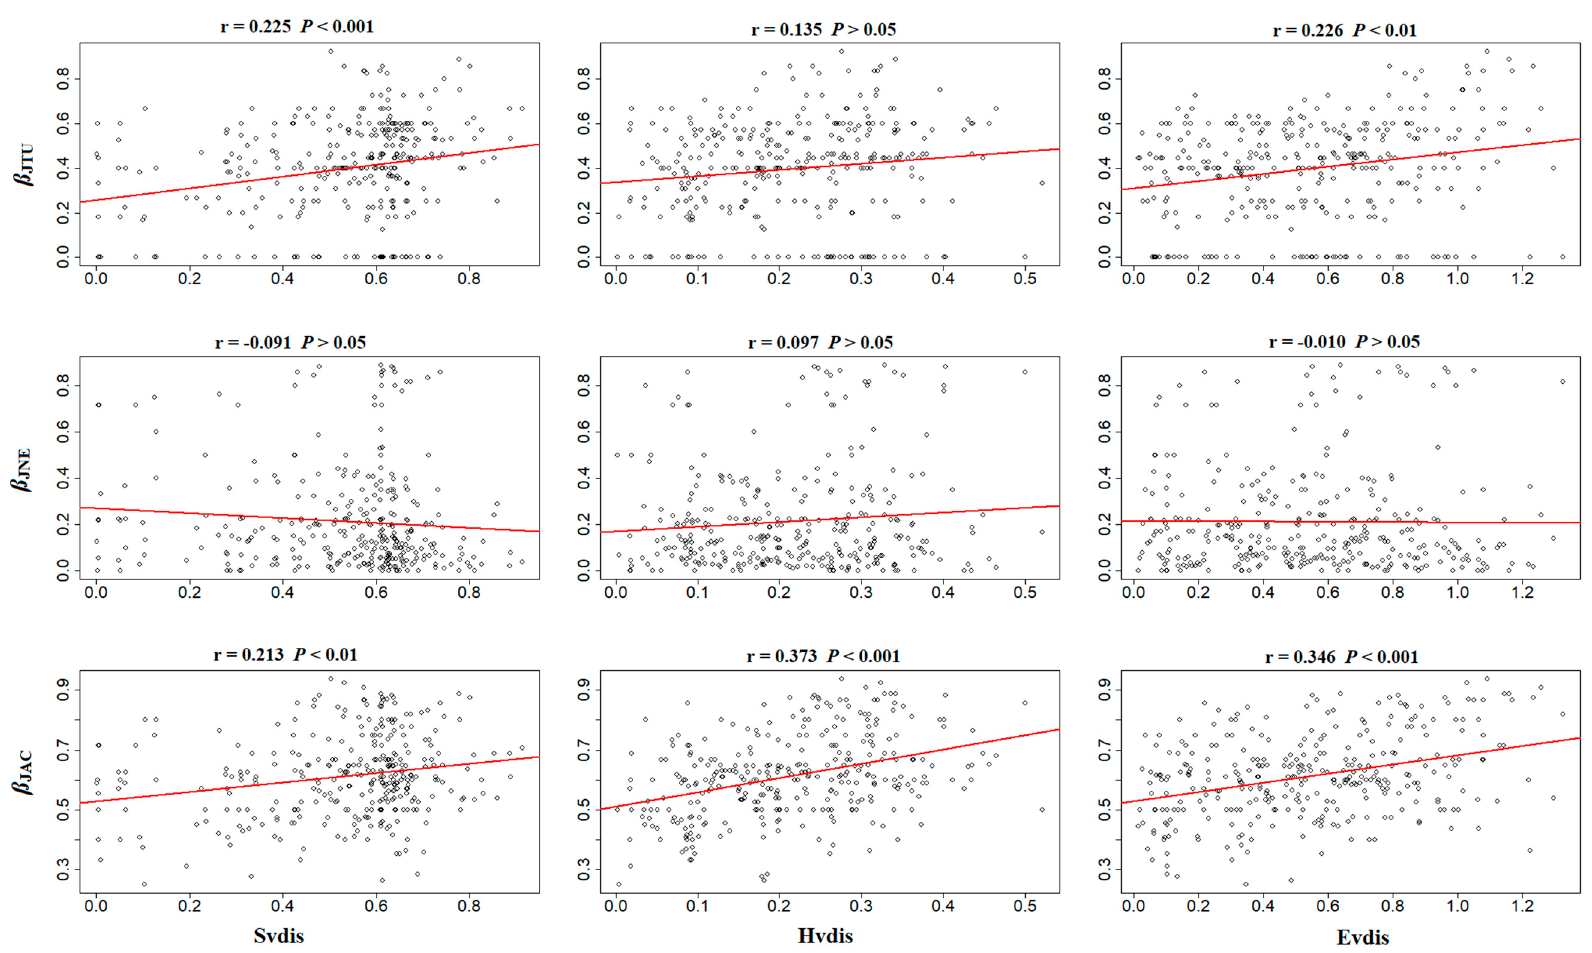
Figure 5. Relationship between Jaccard indices ( ß JTU, ß JNE, and ß JAC ) and dissimilarity matrices based on Euclidean distances for spatial (Svdis), hydrological (Hvdis), and environmental (Evdis) variables in upstream Lijiang River. For other abbreviations see Table 1.